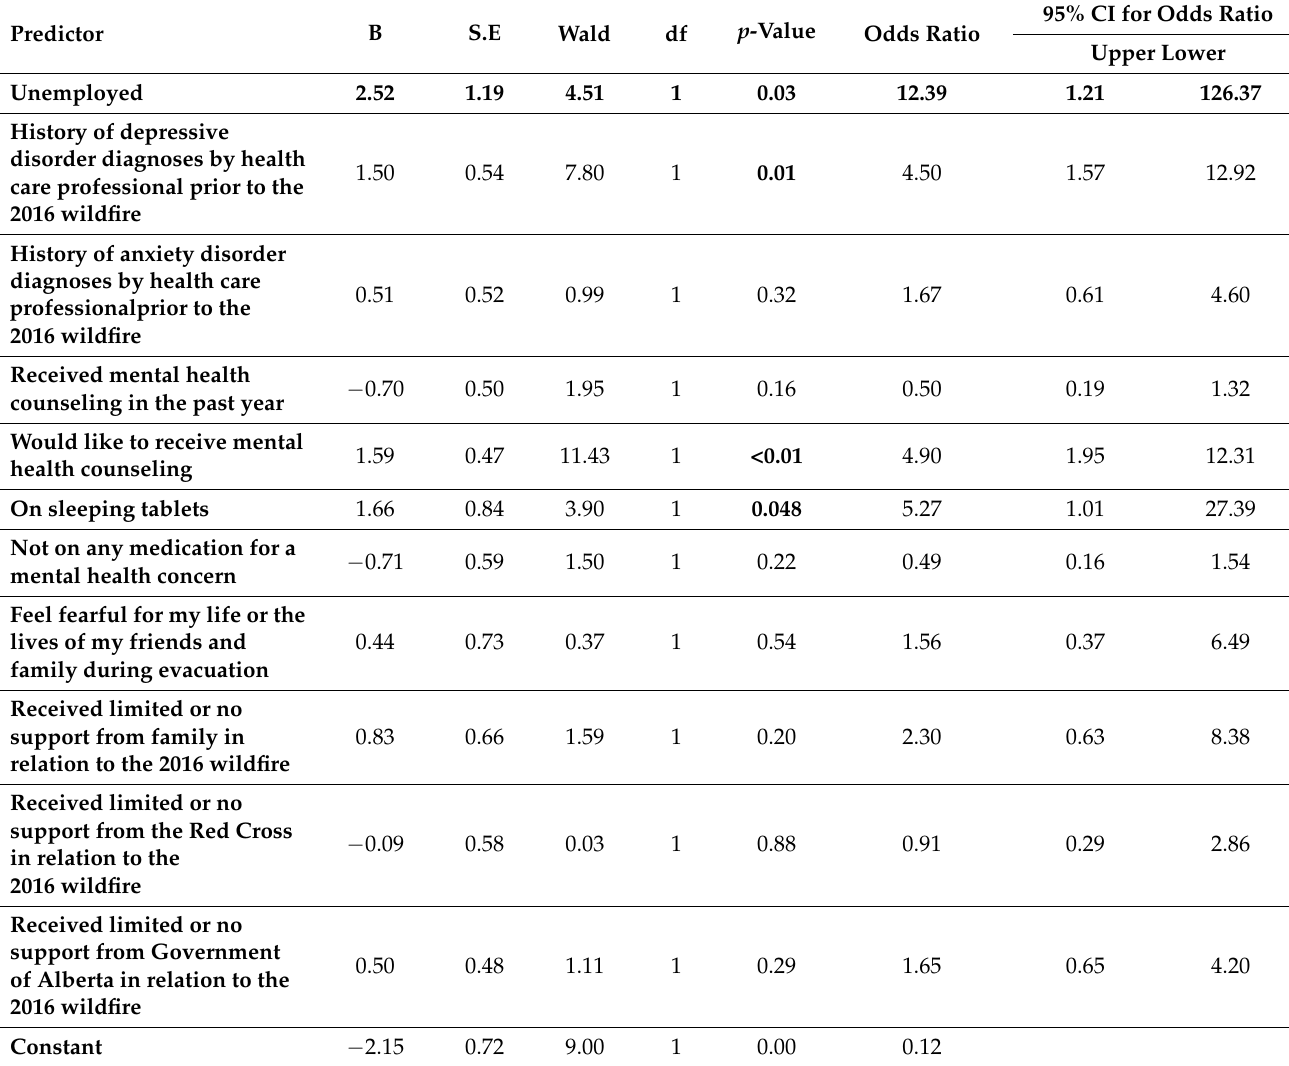
Table 3. Logistic regression predicting the likelihood of residents presenting with